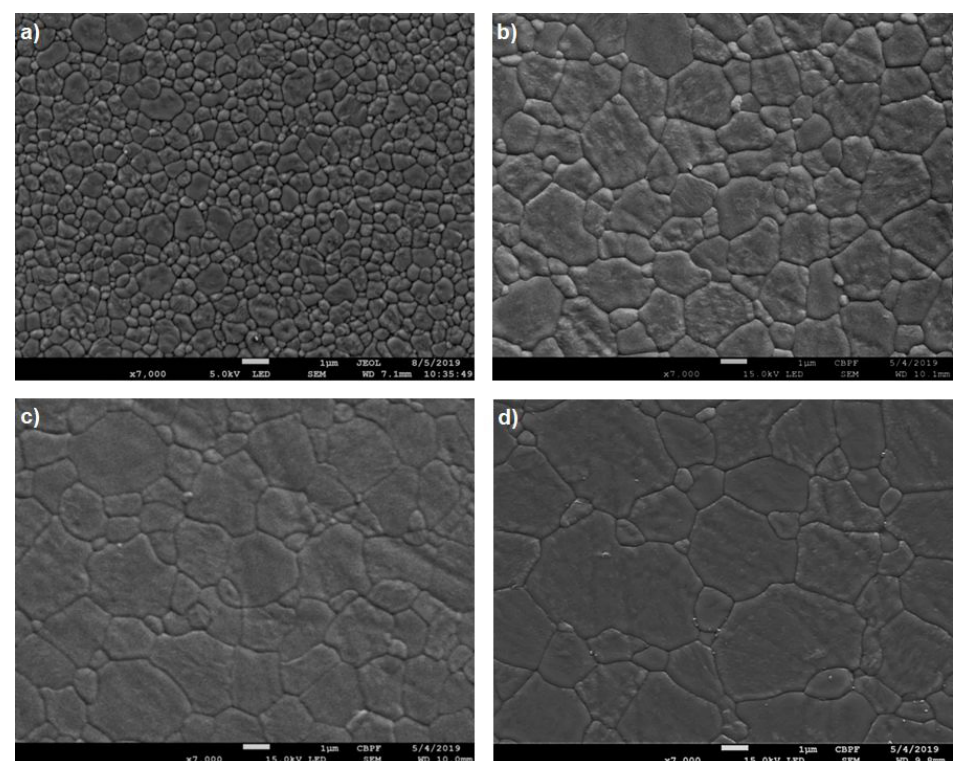
Figure 5. SEM micrographs of G5Y specimens sintered at: a) 1475 °C, b) 1500 °C, c) 1550 °C and d) 1600